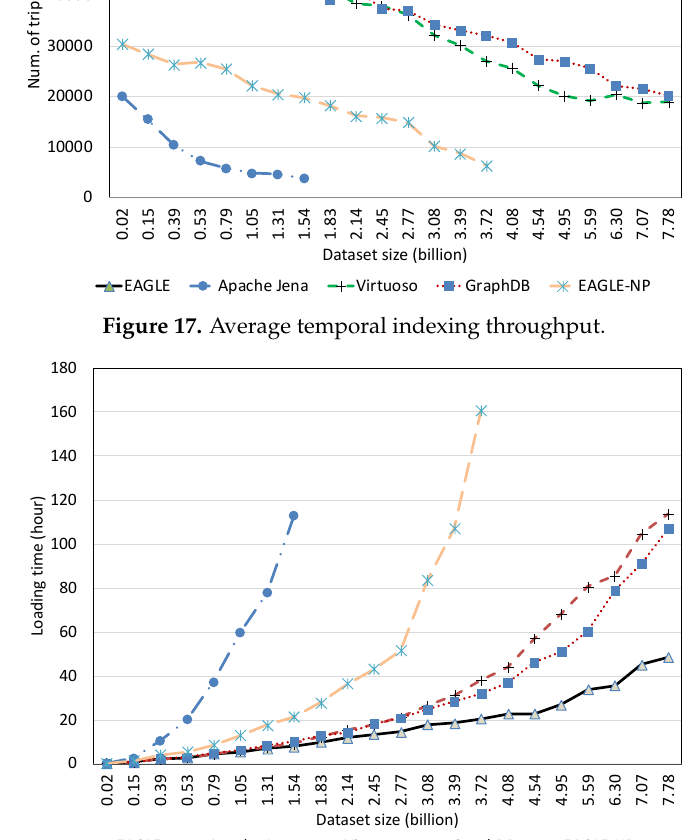
Figure 18. Temporal data loading